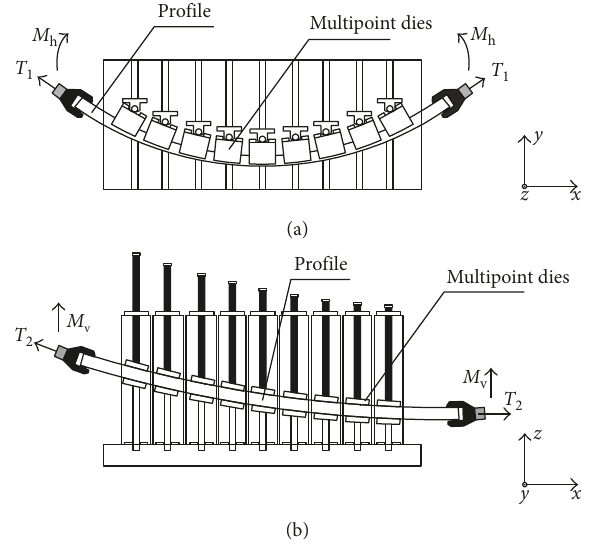
Figure 2: Structure drawing of three-dimensional stretch forming equipment: bending forming in (a) horizontal and (b) vertical